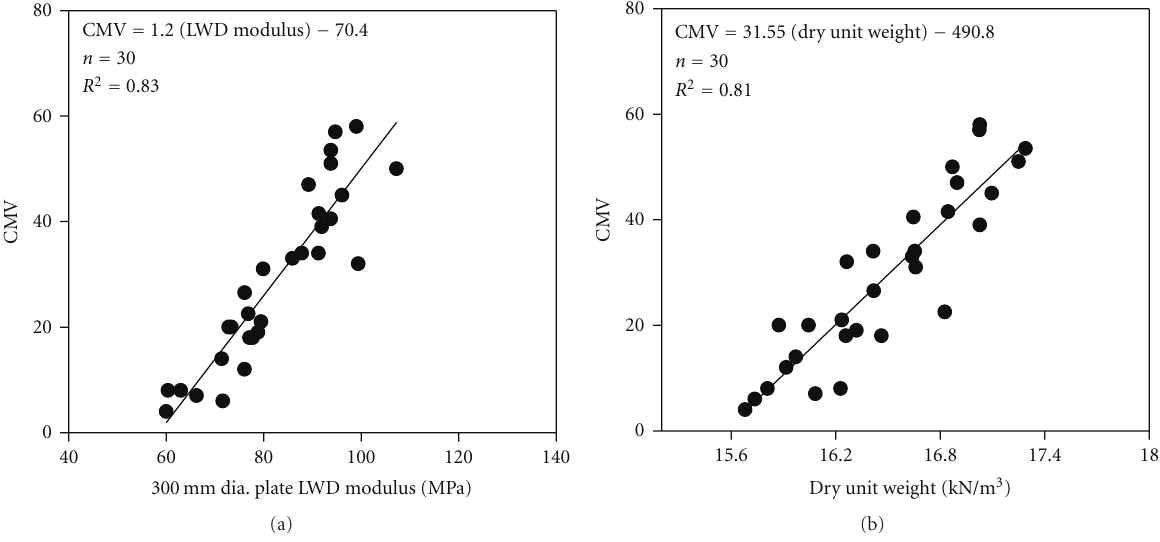
Figure 2: Simple linear regressions between CMV (amplitude = 1.00mm) and in situ point measurements (LWD modulus and dry unit weight)—silty sand with gravel underlain by fly ash stabilized